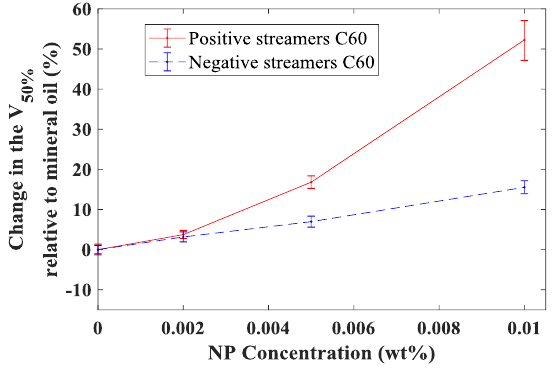
Figure 11. Change in 𝑉 50% of C 60 nanofluids relative to mineral oil as a function of mass fraction 𝑤 𝑖